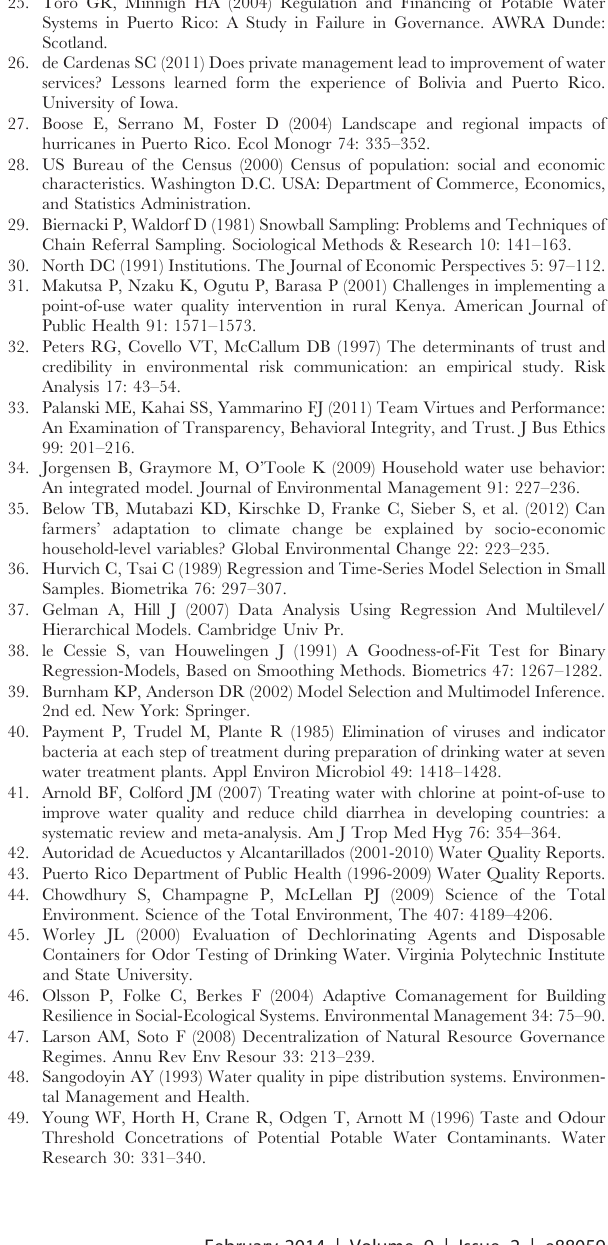
Figure S1 Free chlorine levels in ppm in PRASA and non-PRASA communities across our survey area. Data for PRASA communities were obtained from government databases collected at the barrio level, and data for non-PRASA commu- nities were collected by our field team across several of our study communities of interest. These data suggest that free chlorine levels are typically lower in non-PRASA communities than PRASA communities, and several PRASA measurements have free chlorine levels higher than those recommended by the EPA (4.0 ppm, dotted horizontal line). This suggests that there may be over-chlorination in some PRASA communities. Table S1 Number of interviewees in Non-PRASA and PRASA communities in our two study municipalities. We